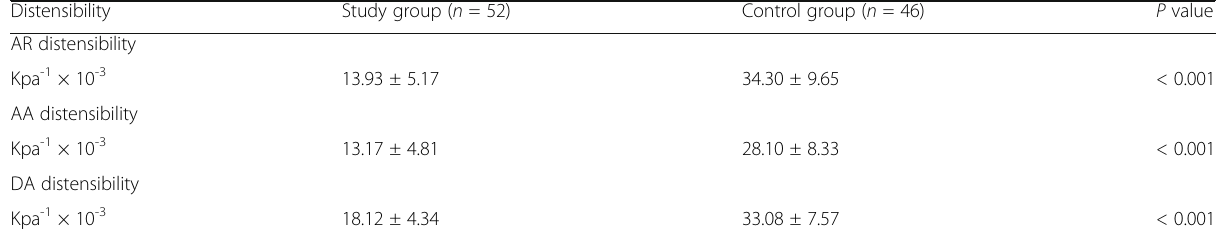
Table 2 Aortic distensibility in study and control groups